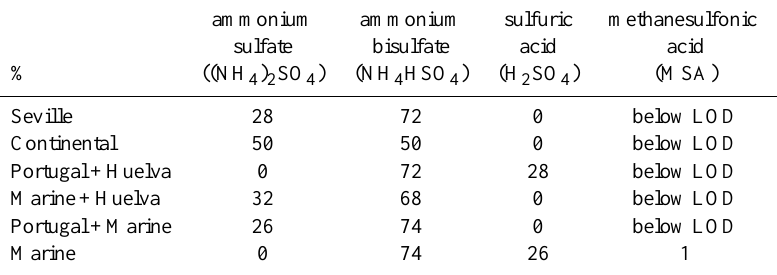
Table 3. Percentage contribution of ammonium sulfate ((NH 4 ) 2 SO 4 ) , ammonium bisulfate (NH 4 HSO 4 ) , sulfuric acid (H 2 SO 4 ) and methanesulfonic acid (MSA) to the species class “sulfate” for the selected air mass